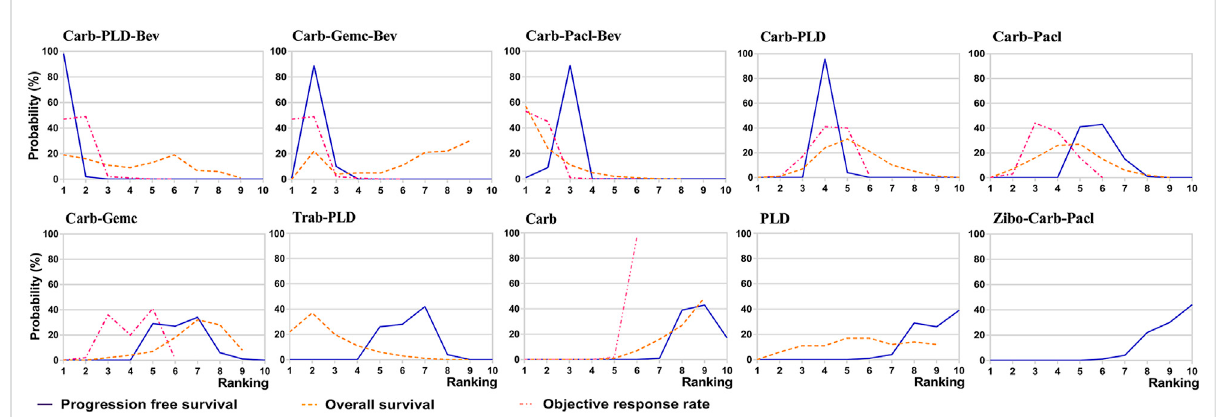
FIGURE 7 Bayesian ranking curves of initial treatments based on ef fi cacy. The probability of each comparable treatment ranking from fi rst to last on progression-free survival, overall survival, objective response rate.